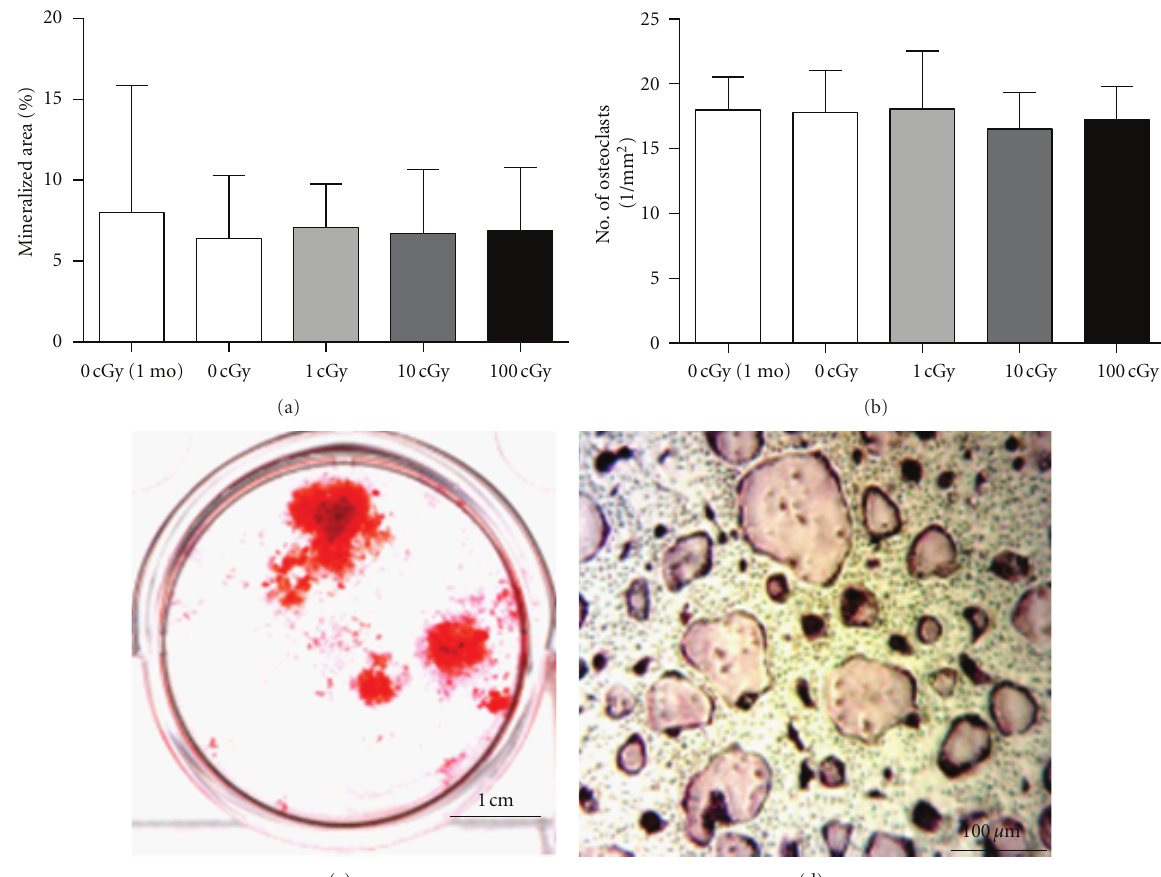
Figure 3: Bone-cell di ff erentiation potential as a function of age and radiation exposure. Hindlimb bone marrow was flushed and cultured under osteoblastogenic or osteoclastogenic conditions to assess di ff erentiation potential of the marrow. Between 1 and 4 months of aging (white columns), osteoblastogenesis (a), measured as the area of calcified matrix per well, and osteoclastogenesis (b), measured as number of TRAP-positive, multinuclear ( ≥ 3/cell) cells per area, remained constant in sham-control mice. Irradiation, at any dose (gray or black columns), did not a ff ect the di ff erentiation potential of bone cells in the marrow at 1 (not shown) or 4 months post-IR (a, b). Images of alizarin red-stained mineralized nodules (c) and TRAP-stained osteoclasts (d).